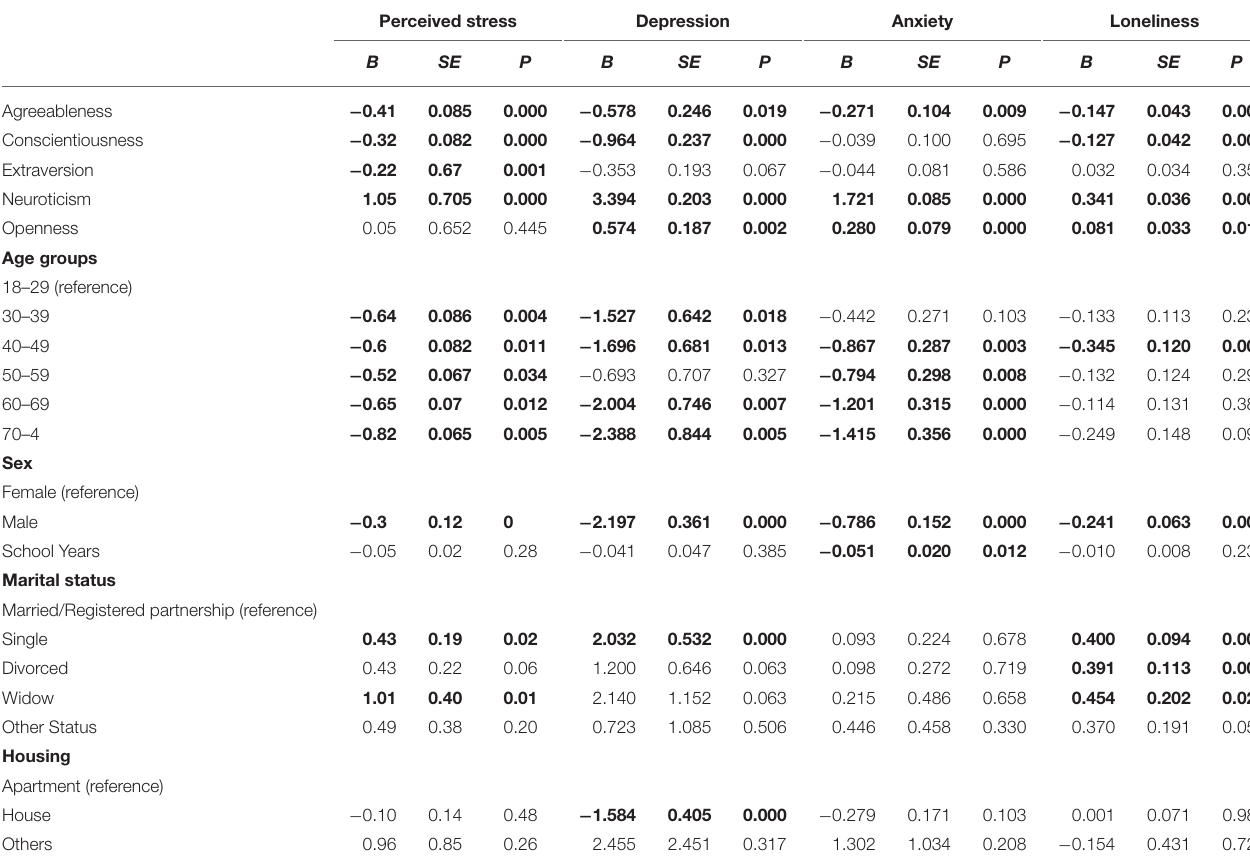
TABLE 2 | Associations of mental health and personality traits outcomes, controlling for sociodemographic variables. Perceived stress Depression Anxiety